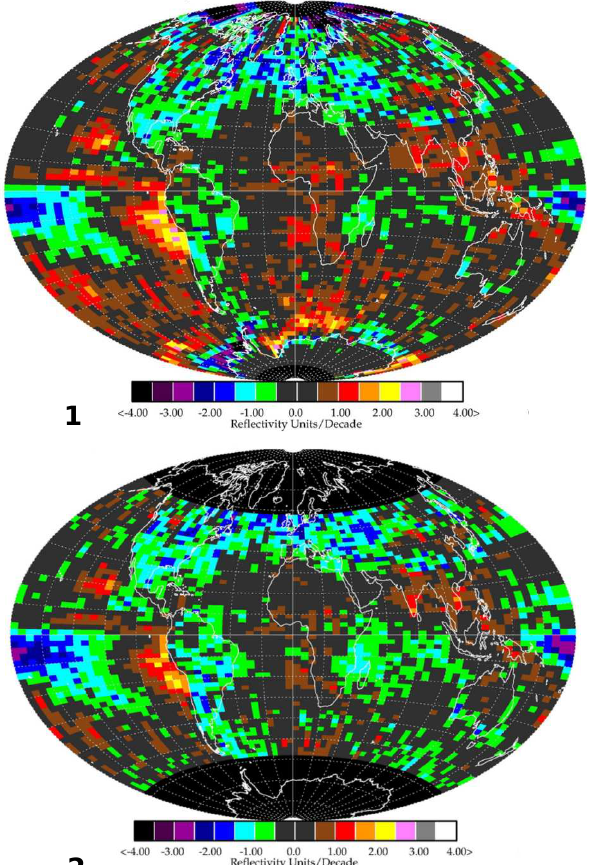
Fig. 11b. LER linear trends 1 LER( θ , ϕ ) as a function of latitude θ and longitude ϕ . The upper panel 3 has land-only zonal average noon normalization corrections applied to the data, while the lower panel 4 is based on ocean-only zonal average noon normalization corrections applied. The noon normalization was not applied to lat- itudes > 60 ◦ because of a lack of measured radiances at different local